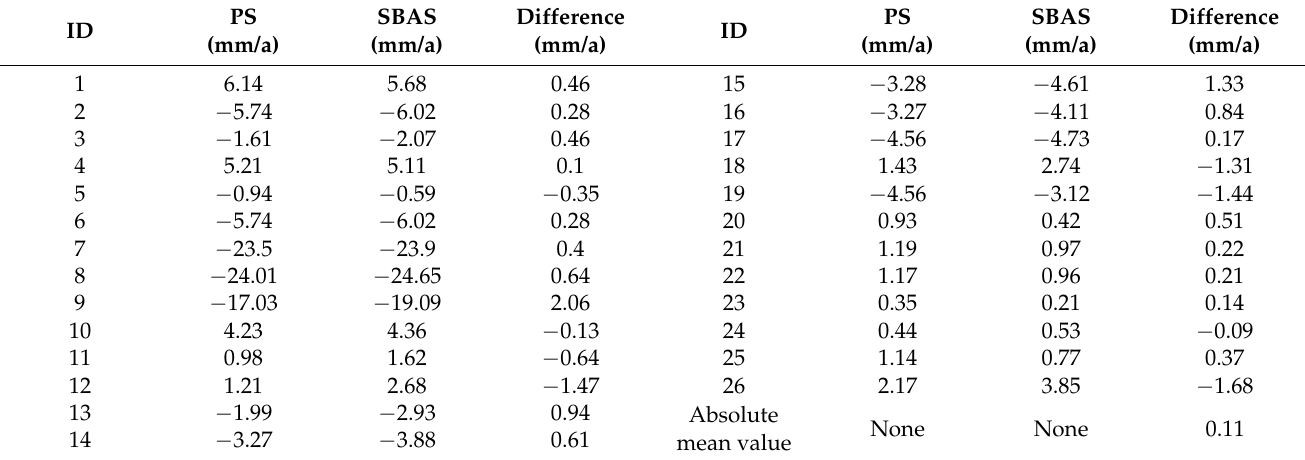
Figure 5. SBAS-InSAR surface point deformation rate diagram.